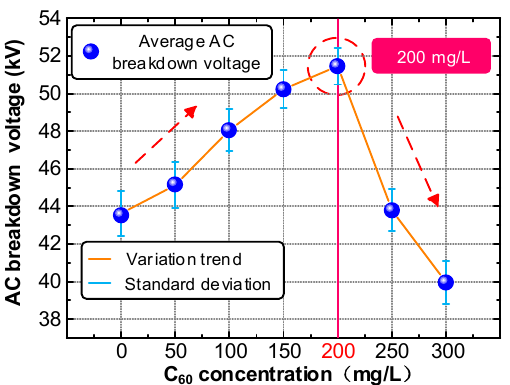
Figure 7. AC breakdown characteristics of CMIO and fresh oil (FO).